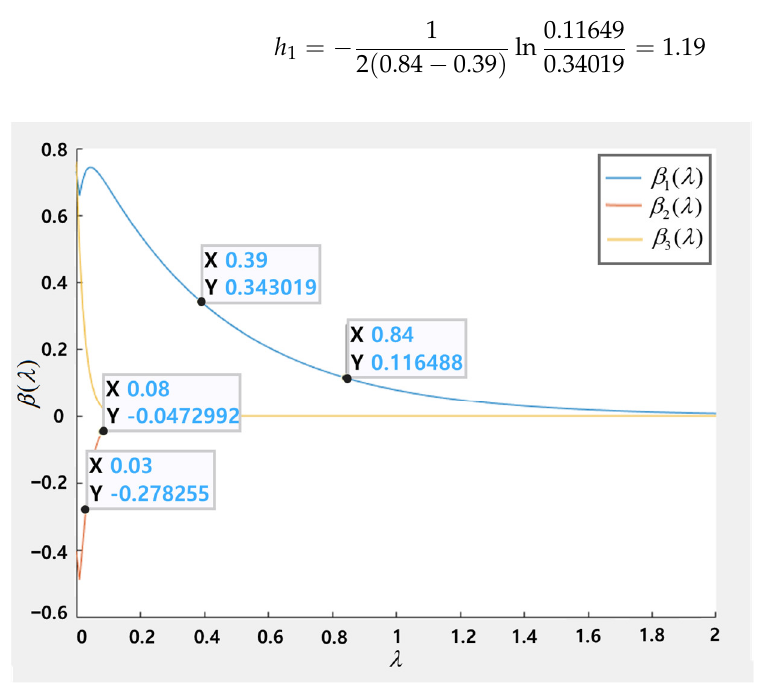
Figure 4. () by the parameters in Table 1. Figure 4. β ( λ ) by the parameters in Table